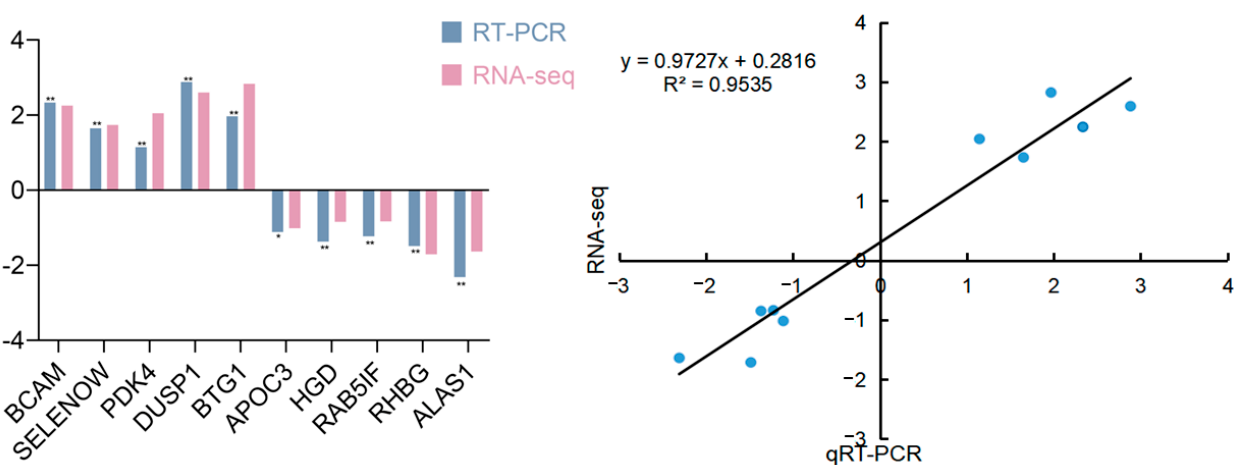
( c ) Figure 6. The relative expressions of CPT1A , ACSL1, and FGF21 in Hu sheep and Tibetan sheep livers via qRT-PCR ( a ) and Western blot analysis ( b , c ). HG is representative of the Hu sheep livers. ZG is representative of Tibetan sheep livers. The data in ( a , c ) are presented as the mean ± SD, n = 3 biologically independent samples; the significant differences (n.s. p > 0.05; * p < 0.05; *** p < 0.001) were performed using two-tailed unpaired t -test. 4. Discussion The mechanisms of fat metabolism are complex. Unlike fat tissue, the liver, as a met- abolic center, is primarily involved in fat metabolism, not just fat deposition. In this study,